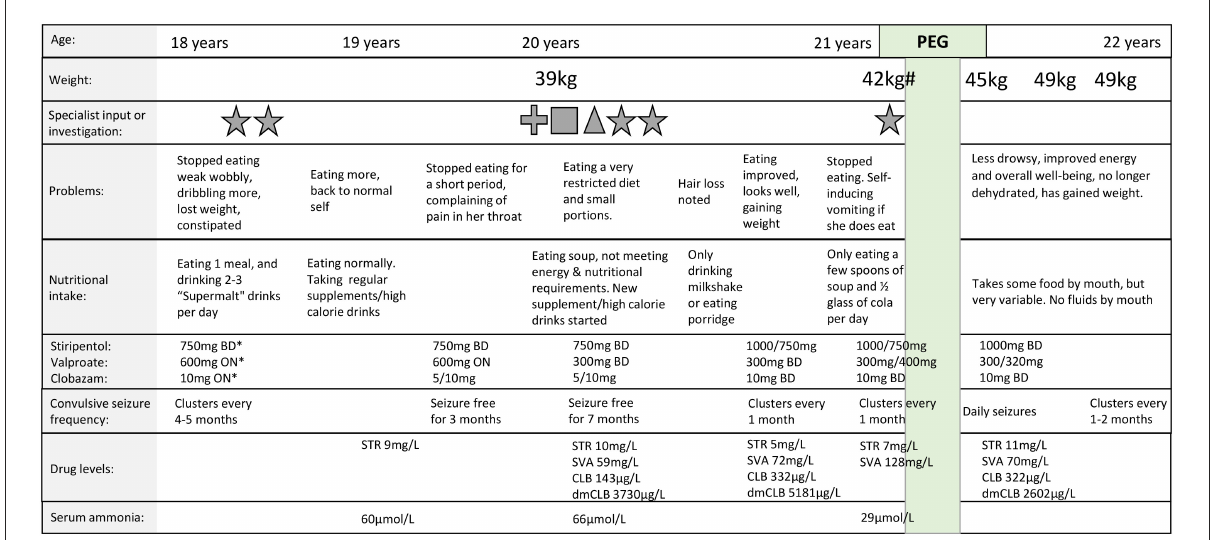
FIGURE1 Timeline of feeding difficulties and percutaneous endoscopic gastrostomy insertion. Feeding difficulties including reduced food and fluid intake and subsequent weight loss fluctuated over 3 years prior to percutaneous endoscopic gastrostomy (PEG) insertion. # = Body mass index (BMI): 16.4 kg/m 2 ; * = The combination of stiripentol (STR), valproate (SVA), and clobazam (CLB) had been prescribed for 4 years prior to symptom onset at 18 years, with no dose increases, or introduction of new medications, in the preceding 3 years; star = dietician review, cross = speech and language therapy review; square = ear nose and throat specialist review; triangle = barium swallow; Green highlight = time of PEG insertion; BD = twice daily, ON = at night; drug doses separated by a forward slash (e.g., 5/10mg) refer to a morning and evening dose;